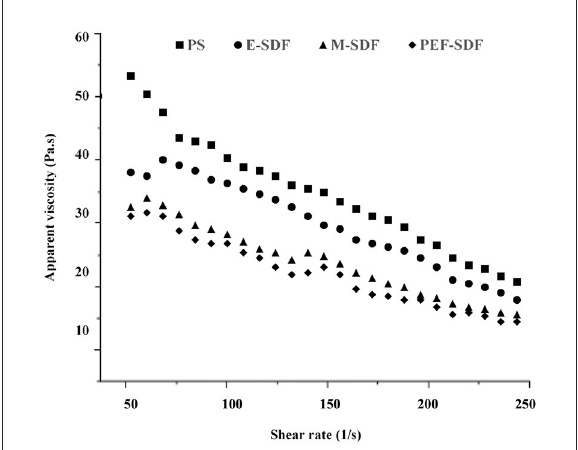
FIGURE2 The dependence of apparent viscosity on the shear rate for of aqueous solution of peanut shell (PS), enzymatic extraction (E-SDF), microwave extraction (M-SDF), and pulsed electric field extraction (PEF-SDF) at concentration of 100 mg/L at 25 ◦